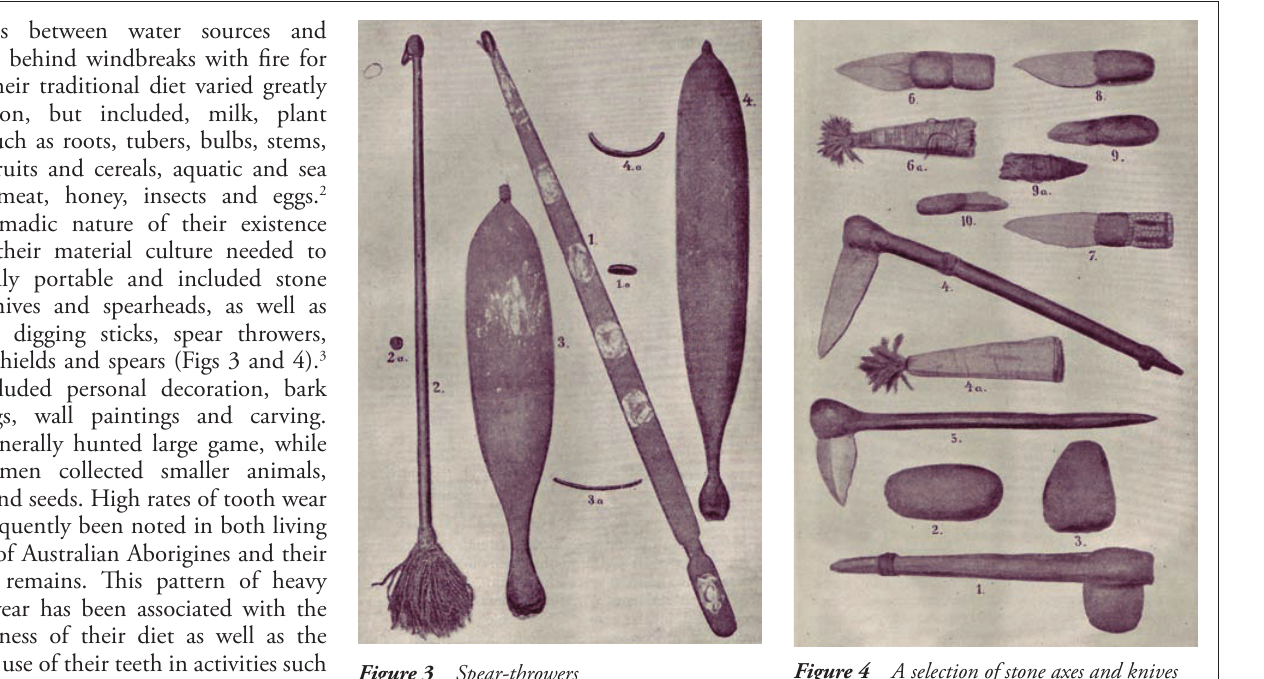
Figure 4 A selection of stone axes and knives Figure 3 Spear-throwers